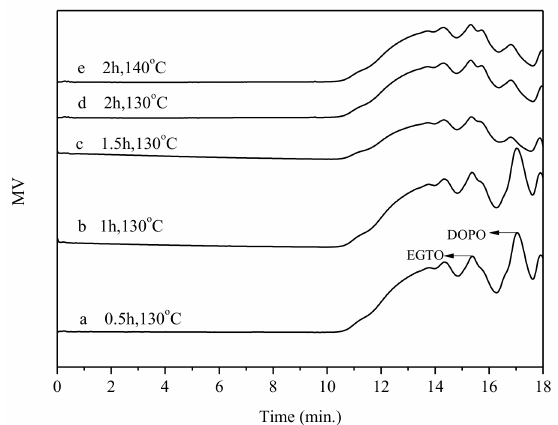
Figure 1. The Gel Permeation Chromatography (GPC) curves of